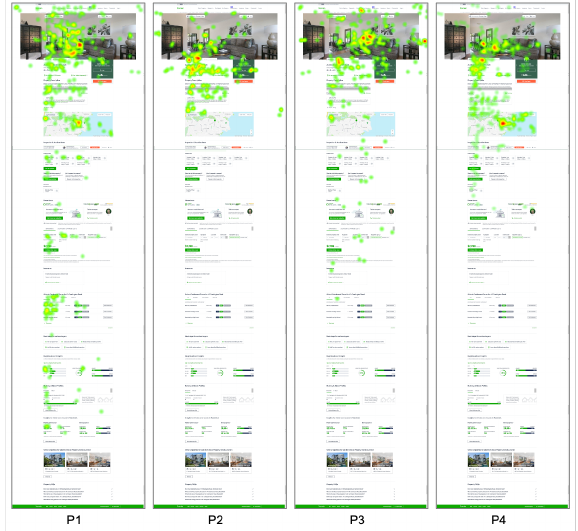
Figure 3. Comparing heat-maps of fixation between 4 different participants on the same property listing.